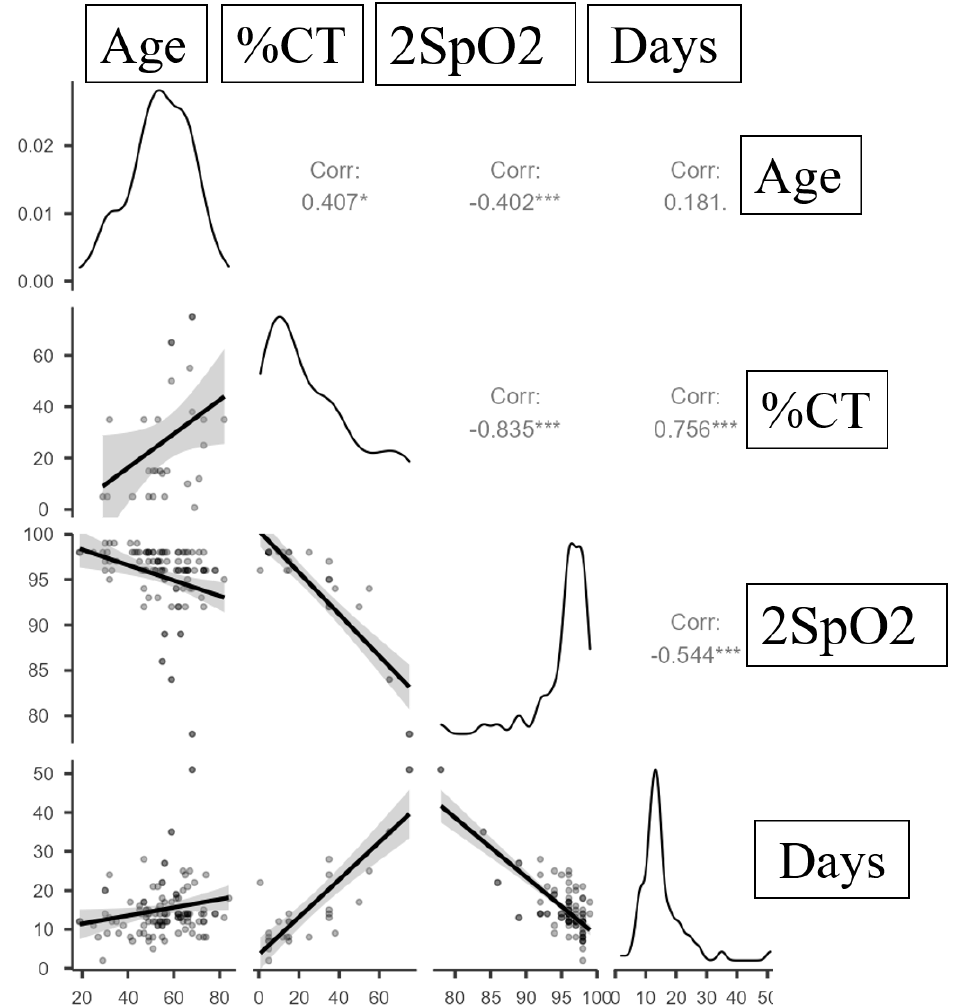
Figure 5. Regression line characterizing the dependence of days in hospital on %CT injuries, 2SpO2 and age. Statistical significance of correlations when * p < 0.05 and *** p < 0.005. Grey zones indicate 95% confidence intervals.